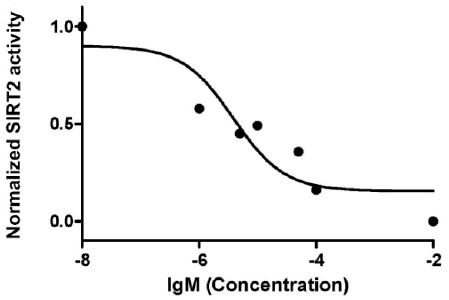
Figure 2. SIRT2 inhibition dose response curves for the most potent compound 7e .